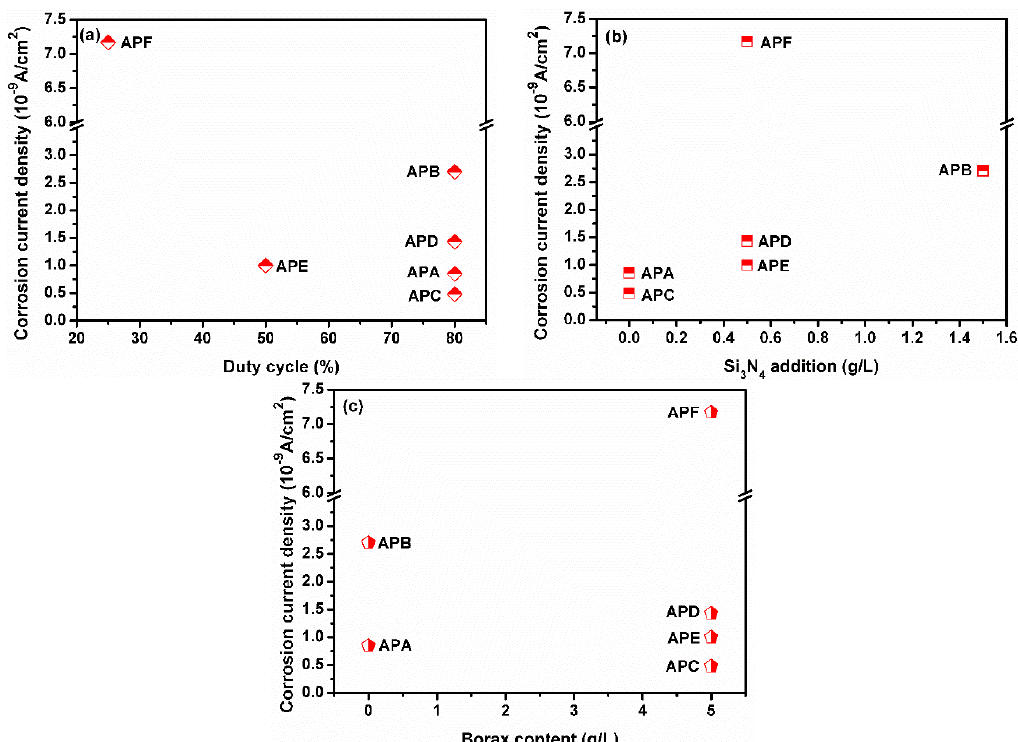
Figure 13. The relationships between corrosion current density and ( a ) duty cycle, ( b ) Si 3 N 4 and ( c ) borax concentrations.